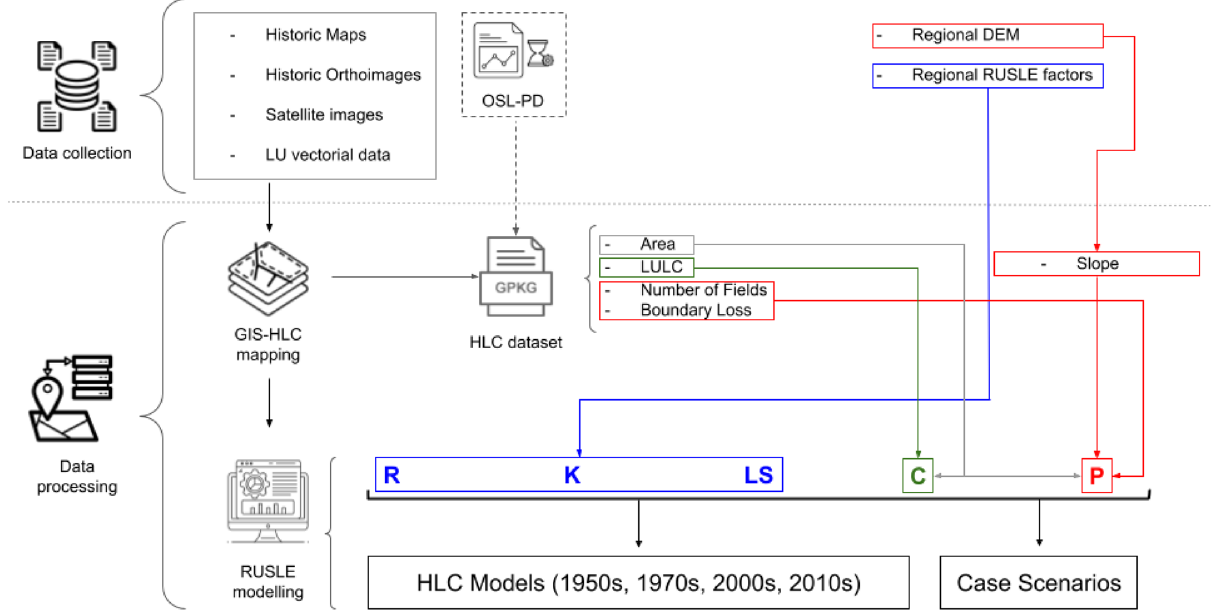
Figure 3. Schematic representation of the workflow employed in this research. The first step (Data Collection) was necessary to develop the HLC dataset employed in the RUSLE equation (Data Processing).